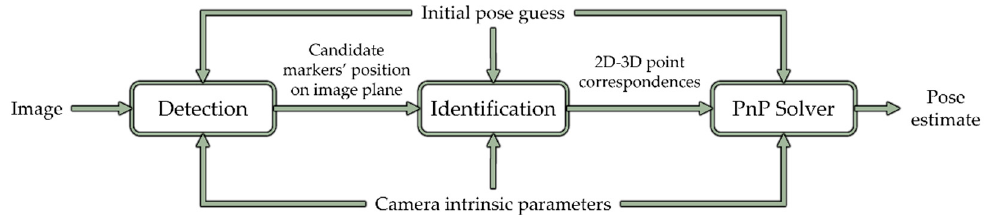
Figure 3. Flow diagram of the general pose determination architecture employed for pose estimation with the chaser-fixed and eye-in-hand cameras.